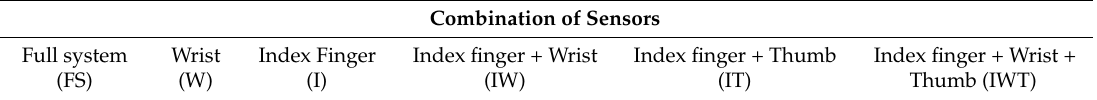
Table 1. Combination of sensors used for the analysis for each